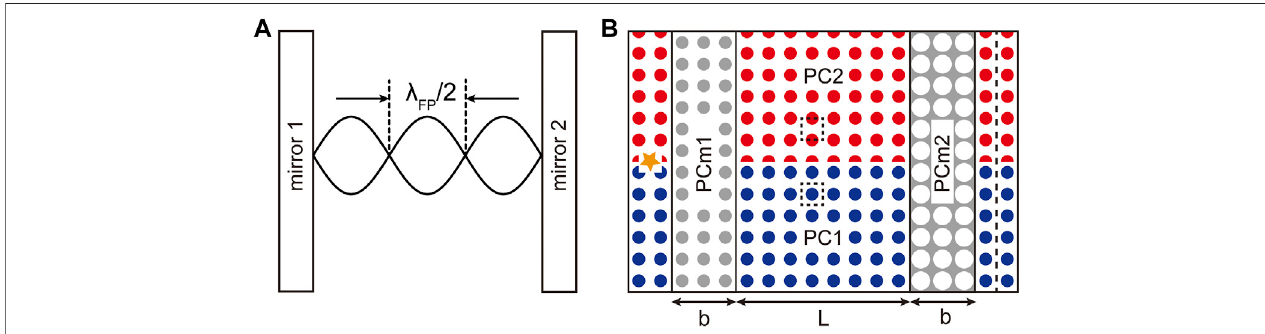
FIGURE1|(A) SketchofatraditionalFPcavity.Lightofwavelength λ FP willexistinsuchacavity. (B) TheschematicdiagramofOTCtype Ⅰ constructedby2DPCs. PC1 and PC2 are with different Zak phases where interface states are induced along their interface within the common photonic bandgap ofPCm1 and PCm2 (in gray). Two PC mirrors are considered to replace the original re fl ecting